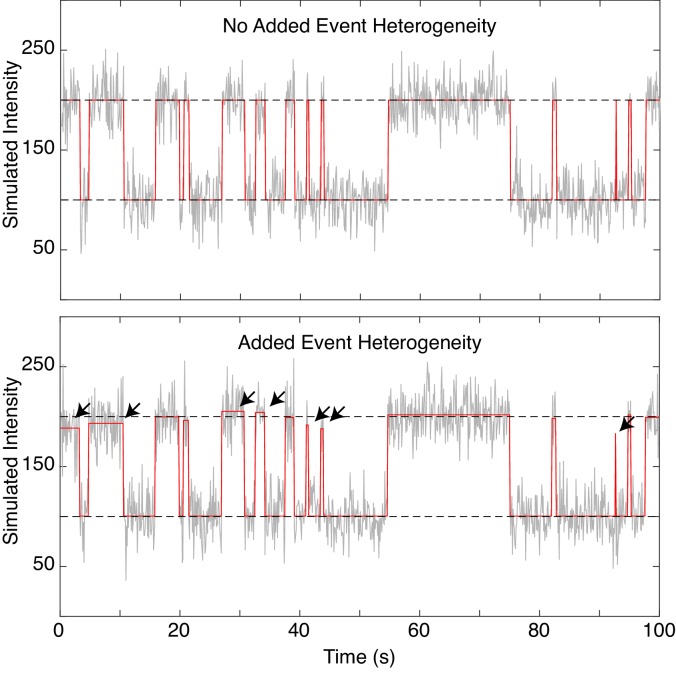
Simulation with heterogenous fcAMP emission.Representative SM simulation of a two-state system both without (top) and without (bottom) heterogeneous emission of fcAMP upon binding. Plots show simulated trajectory (red) overlaid with the addition of Gaussian noise (grey) and the average intensity value of each state (dashed black). Arrows indicate events where the heterogeneous intensities show prominent deviations away from the mean state value.